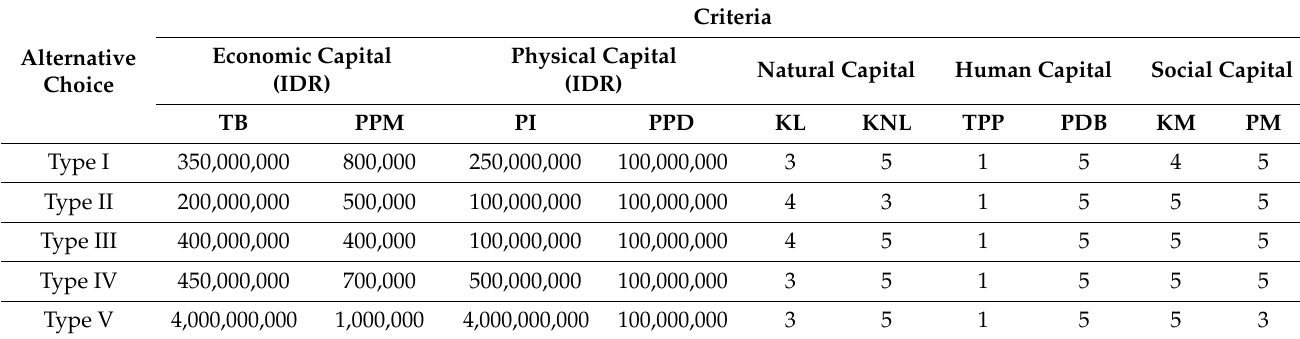
Table 1. Matrix for multicriteria analysis of community-based village development